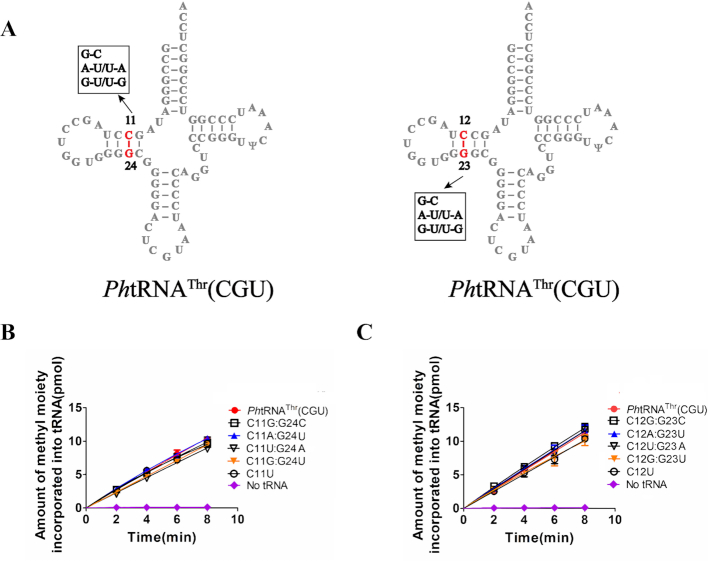
D-stem region is not recognized by PhNSun6. (A) The secondary structure of PhtRNAThr(CGU) summarizing the mutations in C11:G24 and C12:G23 base pairs. The capacity of PhtRNAThr(CGU) with various mutations in C11:G24 (B) and C12:G23 (C) to be methylated by PhNSun6.